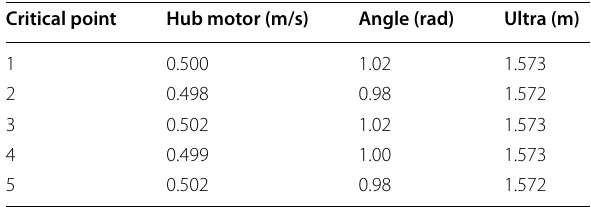
Table 2 Sensor error measurement results